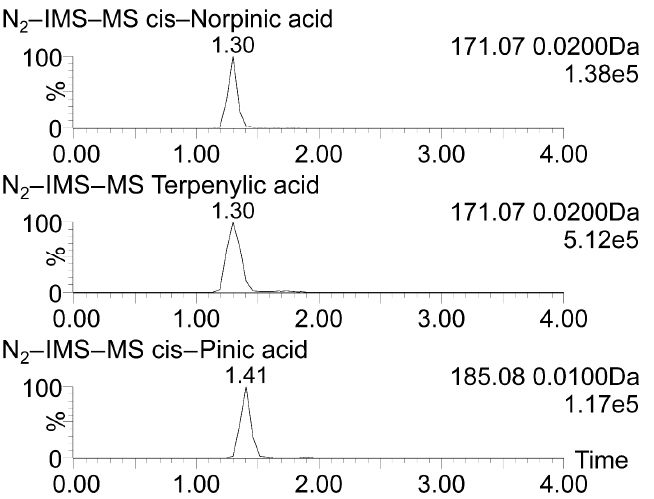
Figure 4 Figure 4. N 2 -driftgrams of standard compounds. The top panel shows cis -norpinic acid ( m / z 171, C 8 H 11 O 4- ), the middle panel shows terpenylic acid ( m / z 171, C 8 H 11 O 4- ), and the bottom panel shows cis -pinic acid ( m / z 185, C 9 H 13 O 4- ). The time axis is in